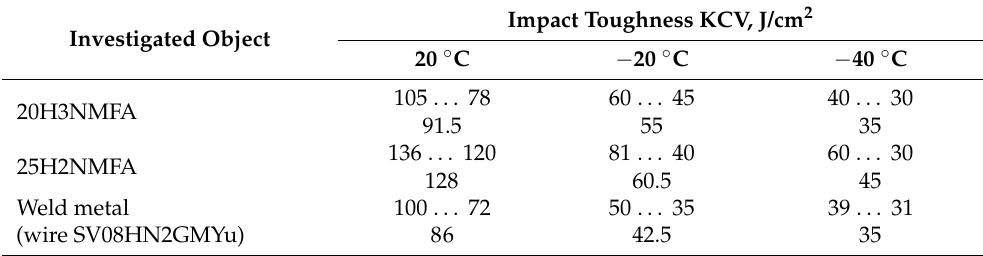
Table 2. The toughness of the weld metal of the combined welds after tempering at 630 °C for 30 h.